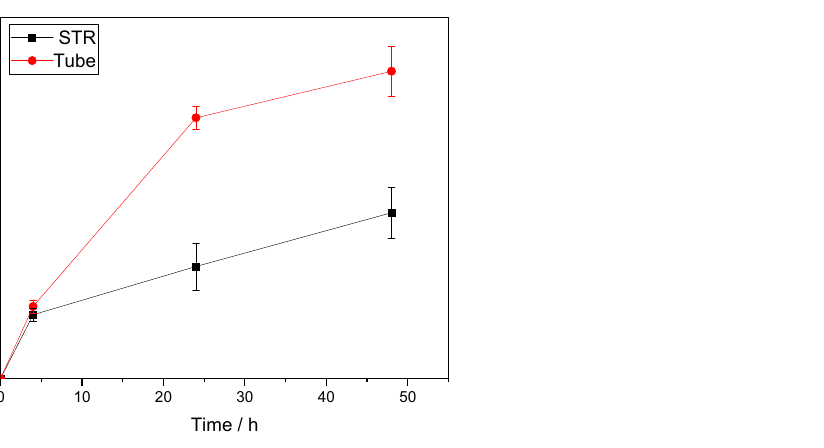
Figure 5. Time course of SL production (g/L): STR with 3-bladed spiral propeller versus tube in orbital shaking.